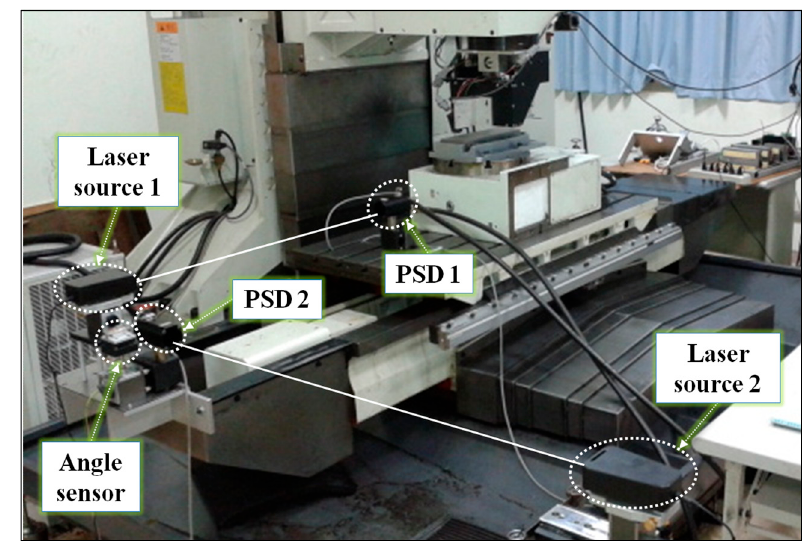
Figure 4. Setup of the dual-axis measurement system.